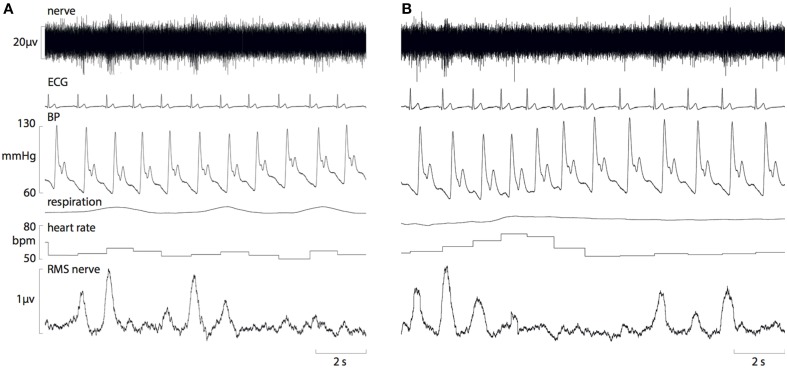
Raw data recordings of MSNA, ECG, blood pressure and respiration in a 25-year old male in the morning (A) and afternoon (B). A fall in diastolic pressure is associated with a baroreflex-driven increase in MSNA, and a rise in diastolic pressure causes inhibition of MSNA bursts.